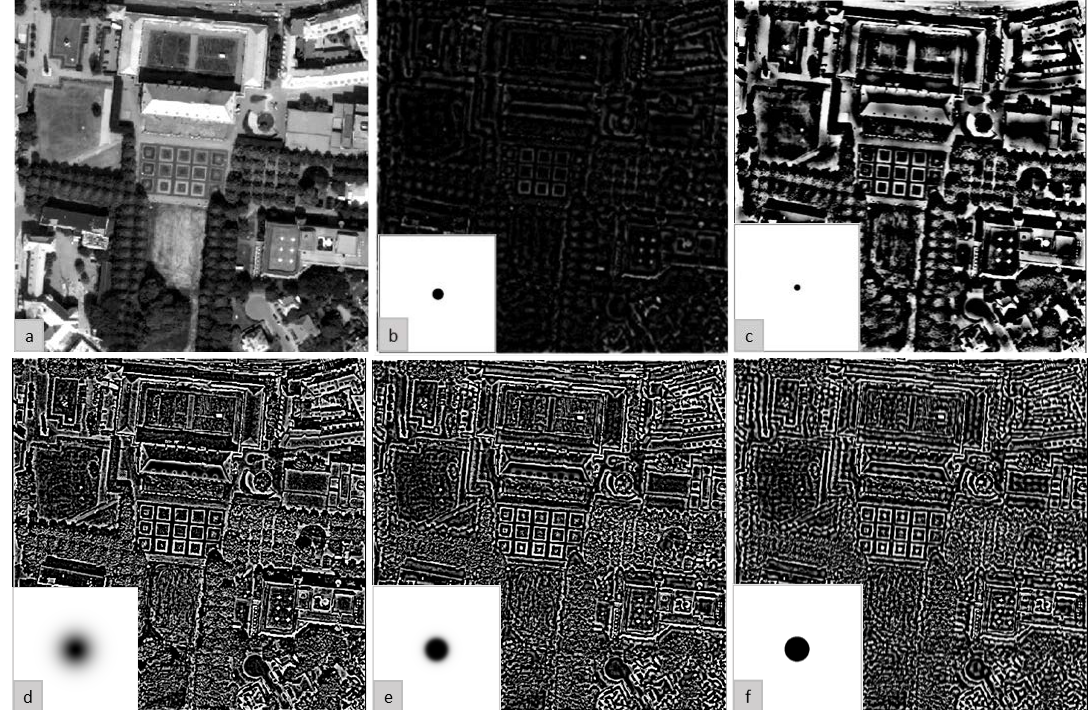
Figure 2. Different high-pass effects. (a) is the original grayscale image (512 × 512 pixels). (b) is the ideal high-pass filtered image (cut-off size of 50). (c) is the ideal high-pass filtered image (cut-off size of 25). (d) is the Gaussian high-pass filtered image (cut-off size of 100) with further enhancement. (e) is the Butterworth high-pass filtered image (cut-off size of 100) with further enhancement. (f) is the ideal high-pass filtered image (cut-off size of 100) with further